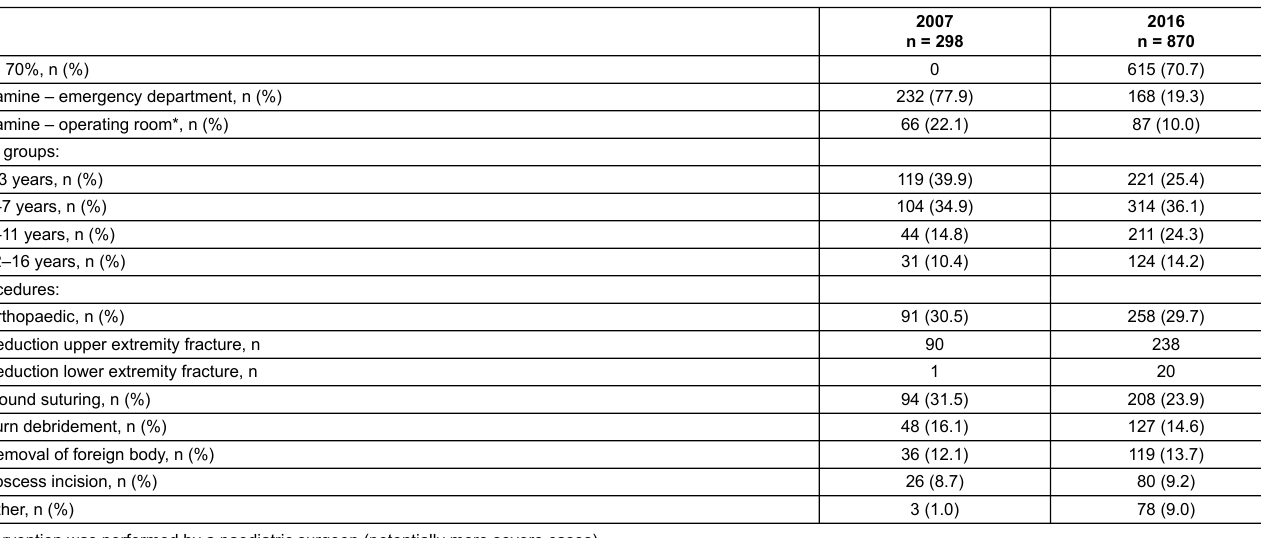
Table 2: Age groups and indications for sedations before (2007) and after (2016) introducing nitrous oxide 70% (N 2 O 70%)